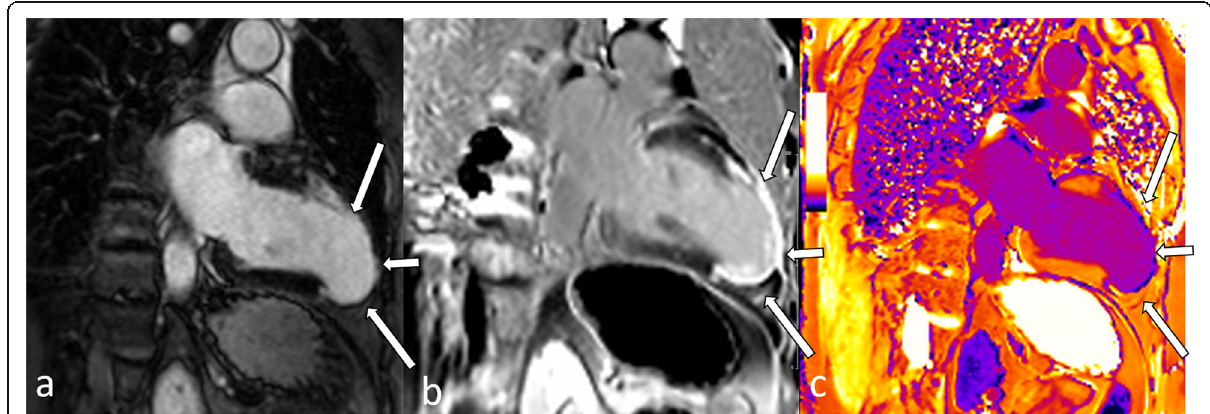
Fig. 5 Eighty-year-old woman with chronic antero-apical myocardial infarction. The affected left ventricular territory is shown by blue arrows in the corresponding conventional LGE image ( a ), dark-blood LGE image ( b ), according to Holtackers et al. [110], and post-contrast T1 map ( c ).